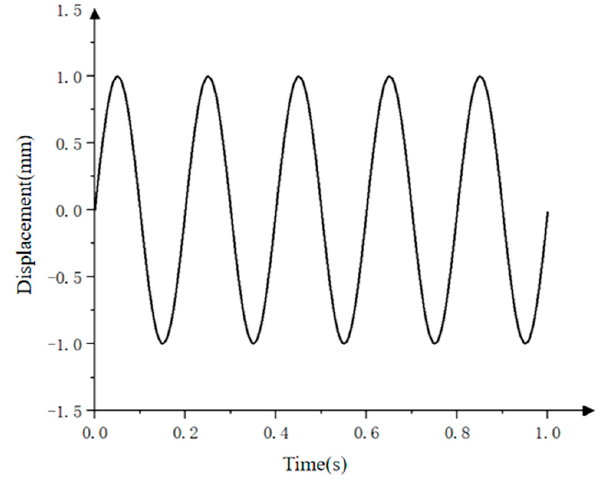
Figure 12. Displacement loading function.